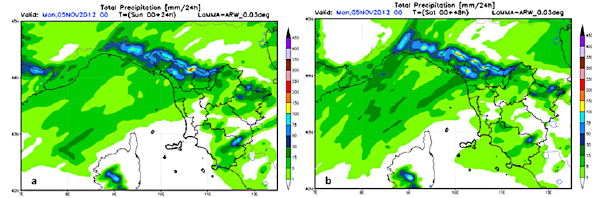
Figure 23. WRF-ARW by LaMMA: 24h accumulated precipitation for 4 November 2012. (a) + 24h forecast; (b) + 48h